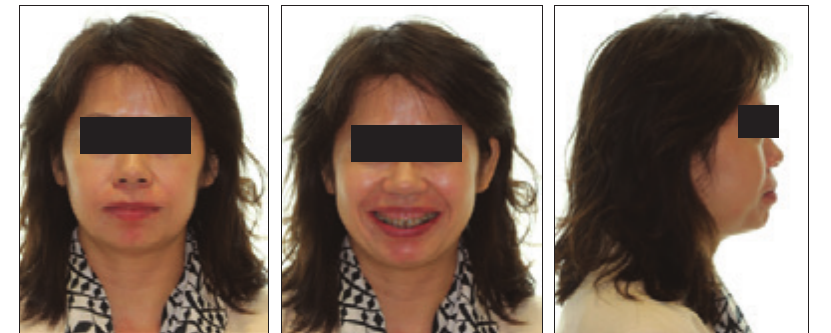
Figure 1. Initial extra-oral